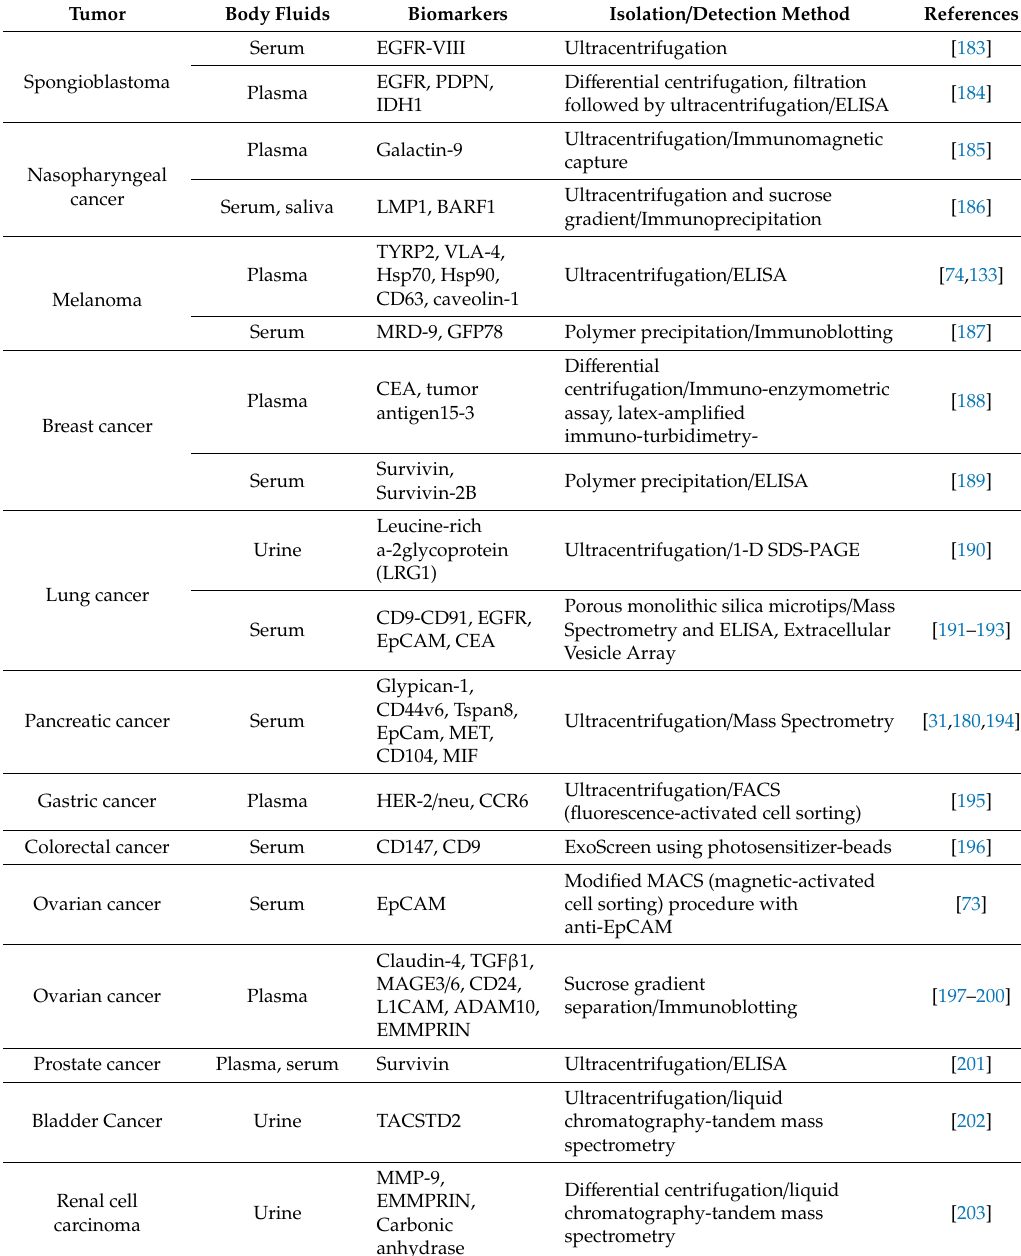
Table 5. Cancer EEVs protein